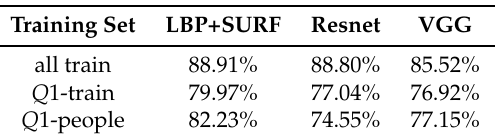
Table 4. Comparison of the performance achieved with models trained using a either all the images available or a subset of images selected according to their coverage. The performance shown is the one achieved when the SVM classifies all testing images.